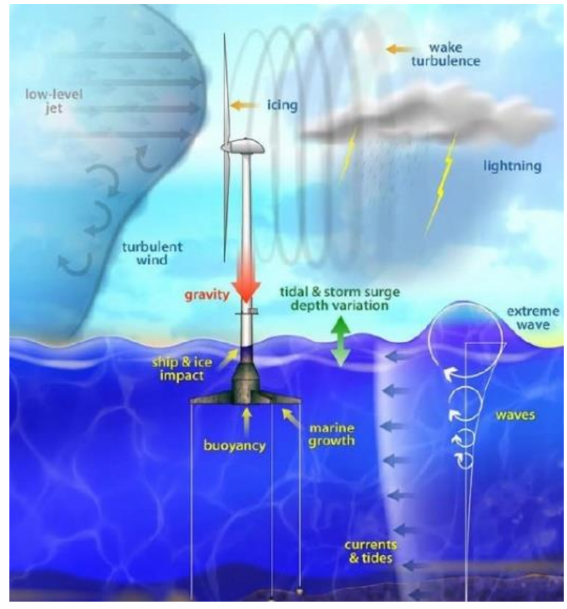
Figure 5. Offshore floating wind turbine loading sources; Reprint with permission [37]; 2007,